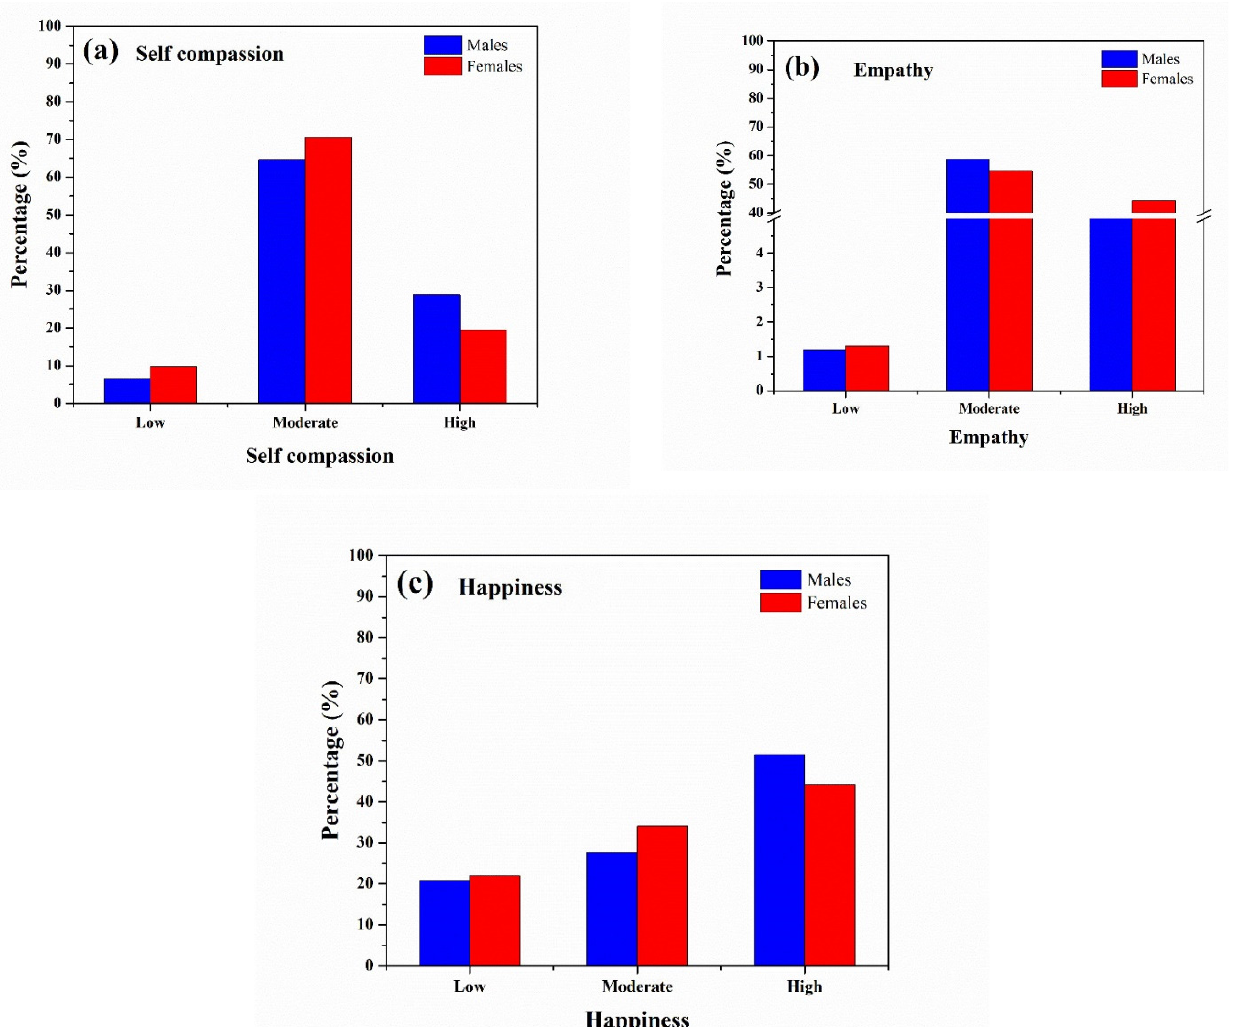
Figure 1. Levels of self-compassion, empathy, and happiness among males and